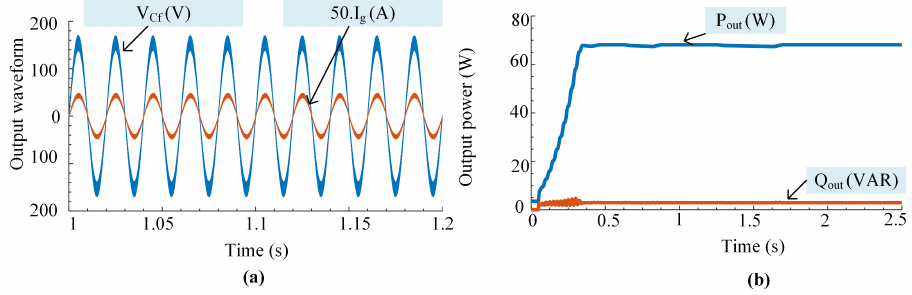
Figure 10. ( a ) Injected current and output voltage. ( b ) Active and reactive power at the output side.